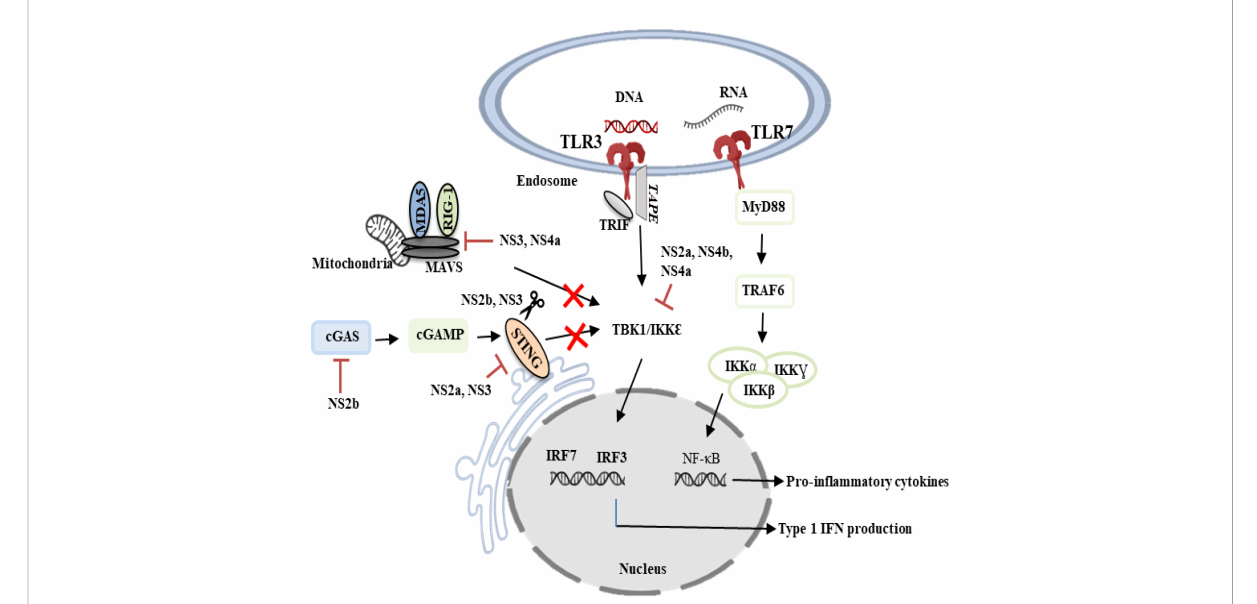
FIGURE 1 DENV evasion of innate immune responses. DENV non-structural proteins such as NS2a, NS2b, NS3, NS4a and NS4b are known to modulate innate immunity by counteracting the type I IFN-mediated antiviral response. TLR3, Toll-like receptor 3; TLR7, Toll-like receptor 7; NS2a, Non- structural 2a protein; NS2b, Non-structural 2b protein; NS3, Non-structural 3 protein; NS4a, Non-structural 4a protein; NS4b, Non-structural 4b protein; IRF3, Interferon regulatory factor 7; IRF7, Interferon regulatory factor 7; cGAS, Cyclic GMP-AMP synthase; cGAMP, Cyclic GMP-AMP; IKK a , I k B kinase-alpha; IKK b , I k B kinase-beta; IKK Ɣ , I k B kinase-gamma; TRAF6, Tumor necrosis factor receptor-associated factor 6; MAVS, Mitochondrial antiviral signaling; MyD88, Myeloid differentiation primary response gene 88; TBK1/IKK ϵ , TANK-binding kinase 1/I k B kinase- epsilon; RIG-1, Retinoic acid-inducible gene 1; MDA5, Melanoma differentiation-associated protein 5; TRIF, TIR-domain-containing adapter inducing IFN- b